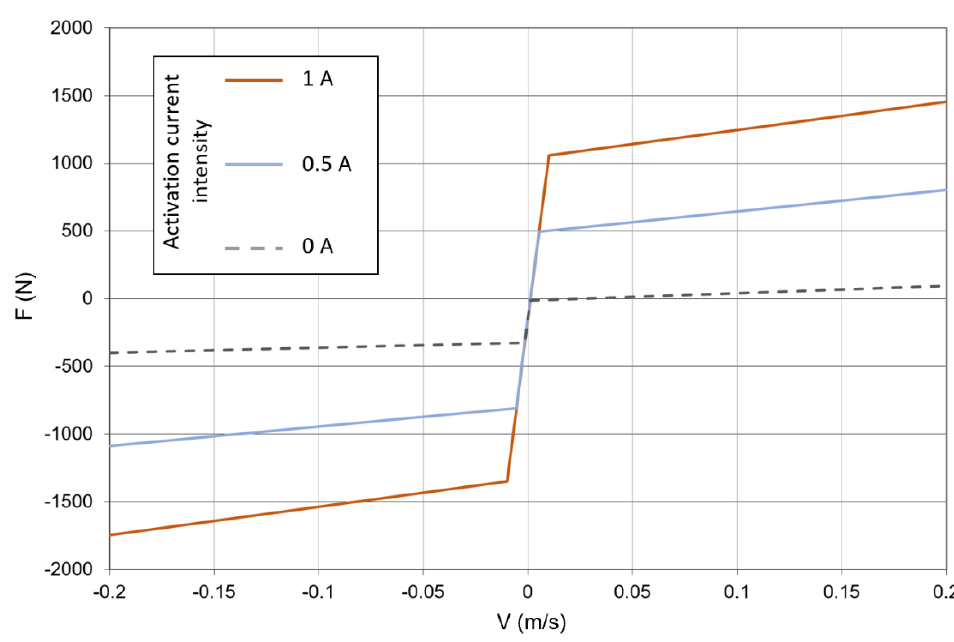
Figure 23. LORD MRD-1005-3, relevant operative curves.